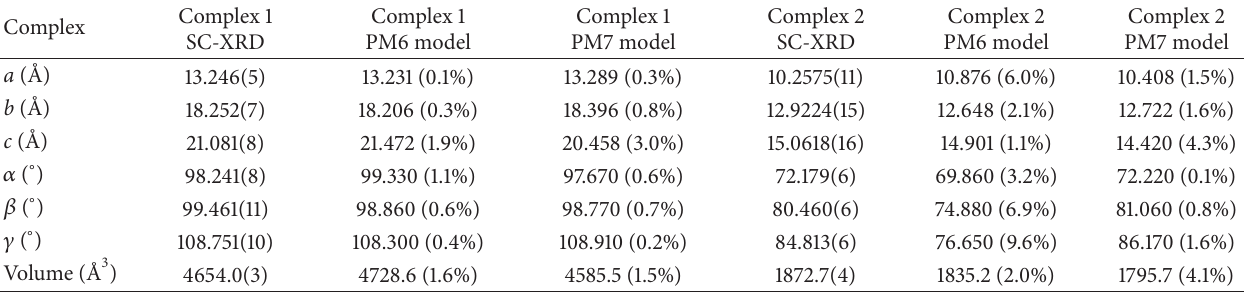
Table 3: Comparison of the unit cell parameters for PM6 and PM7 predicted structures. In parentheses, for the experimental values, standard deviation is shown; for theoretical values, percent error is indicated.